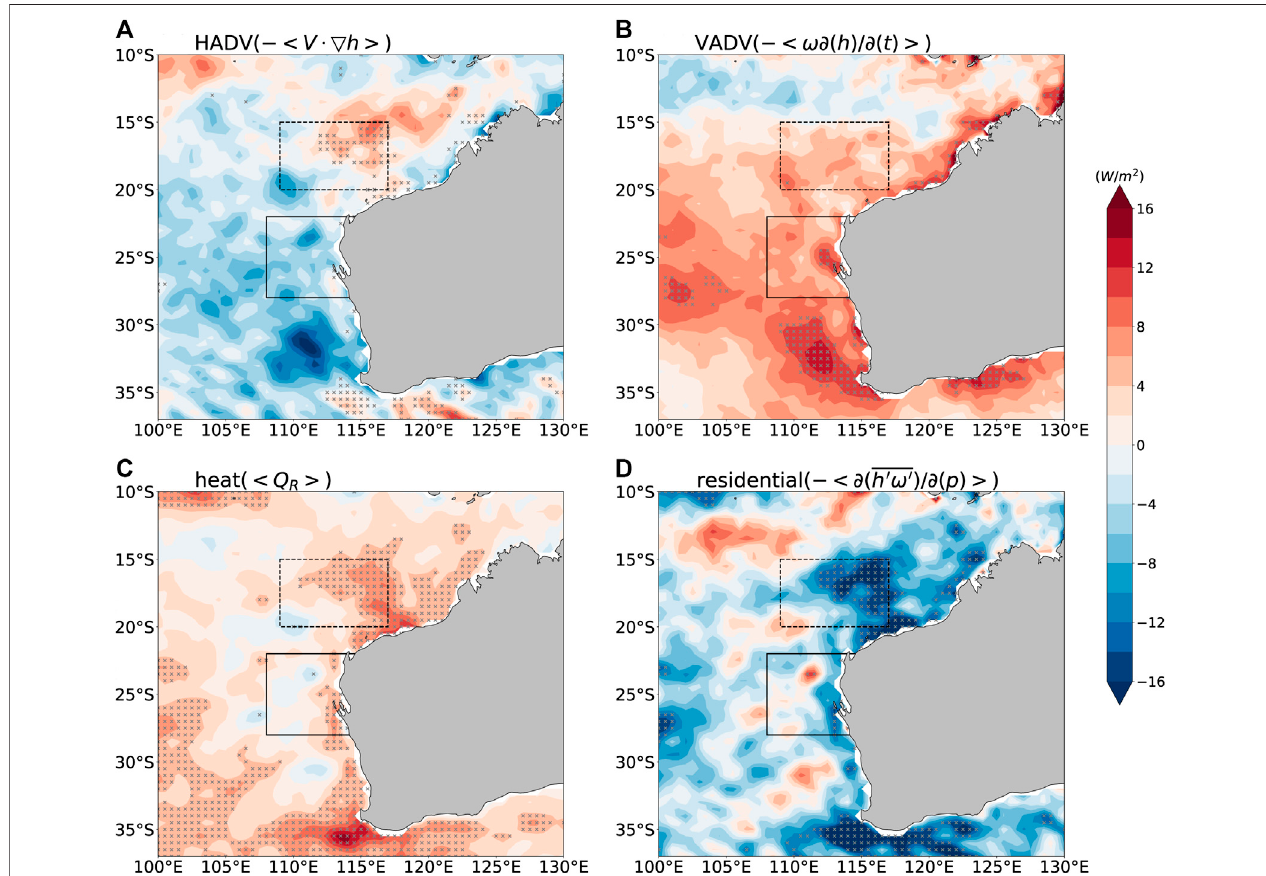
FIGURE 5 | Same as in Figure 4 but for (A) column-integrated horizontal advection of MSE (HADV, W m − 2 ), (B) column-integrated vertical advection of MSE (VADV, W m − 2 ), (C) total heat and radiative forcing ( < Q R > , W m − 2 ) and (D) MSE transport by the subgrid-scale processes (W m − 2 ). The gray crosses indicate the corresponding variable anomalies above the 90% signi fi cance level by a Student t test. The solid and dashed boxes indicate the WA (108 ° E-coast, 28 – 22 ° S) and NWA (109 – 117 ° E, 20 – 15 ° S) coastal regions, respectively.